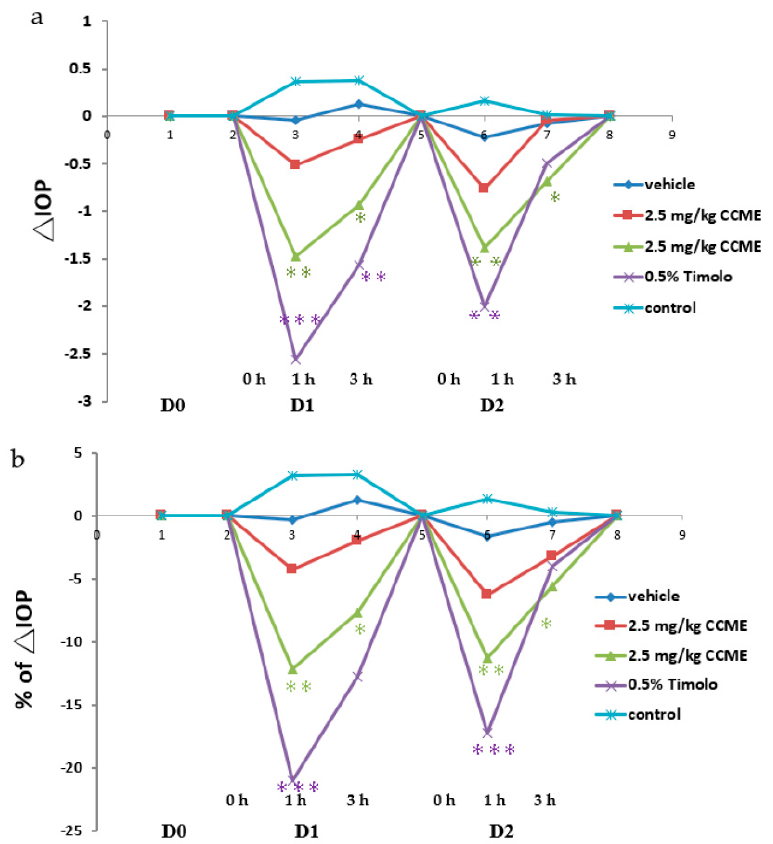
Figure 4. Effect of C. cicadae mycelia extracts on IOP in a rabbit model: ( a ) the ∆ IOP (IOPtime-IOP0) of time course on the normotensive rabbit eye model. Dark blue is vehicle, light blue is control, red is 2.5 mg/kg CCME, green is 25 mg/kg CCME, and purple is Timolol. * p < 0.05, ** p < 0.01 and *** p < 0.001 versus vehicle control group; ( b ) the percentage of ∆ IOP on the ocular normotensive rabbit model. Dark blue is vehicle, light blue is control, red is 2.5 mg/kg CCME, green is 25 mg/kg CCME, and purple is Timolol.